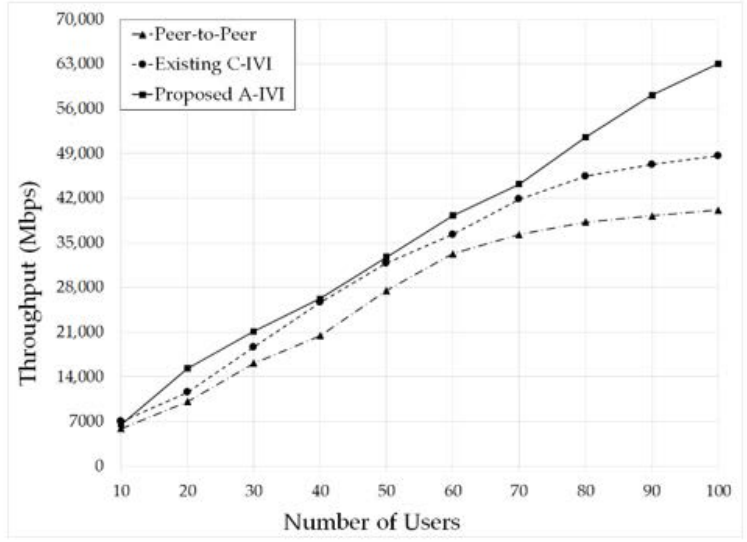
Figure 26. Throughput for different number of users.